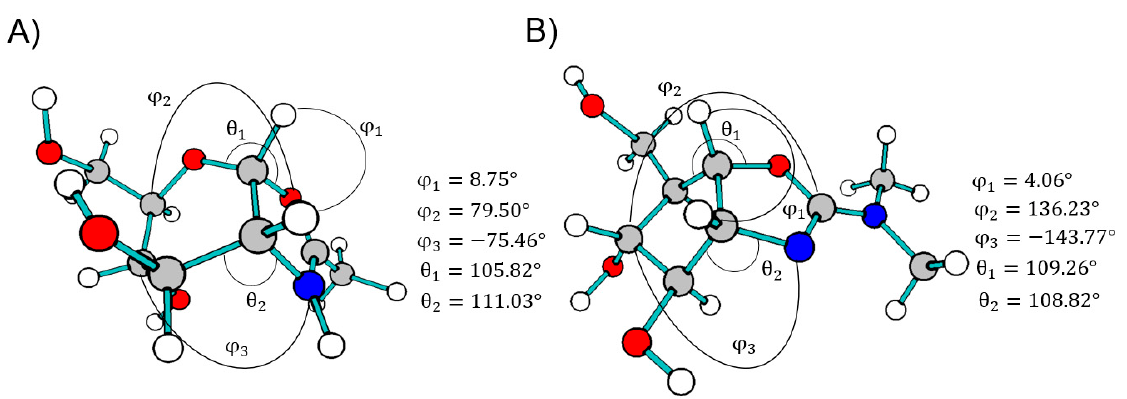
7 of 19 Figure 5. Reaction intermediate, allosamizoline crystal structure, and scaffold structures. We performed a conformer analysis of this hydrolysis intermediate, using PM6 ap- proximation, obtaining 19 conformers. From these geometries, the angles were analyzed and considered for the ligand-based design, and the minimal energy conformation was selected which had a geometry-like bowl (Figure 6 and Table S25, see Supplementary Data). Besides, electronic properties were examined by single-point energy calculations of